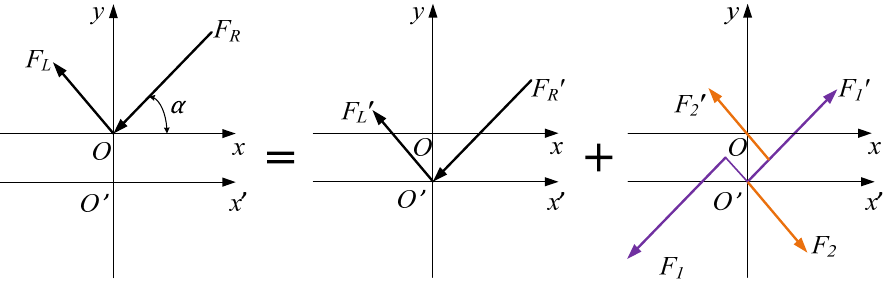
Figure 9. Periodical contact of the cylindrical driving tip and the slider, including three types of Figure 10. Transmission and equivalence of piezoelectric forces along the axis of Langevin contact zones consisting of: (I) impact; (II) rolling; and (III) plastic deformation. transducers.